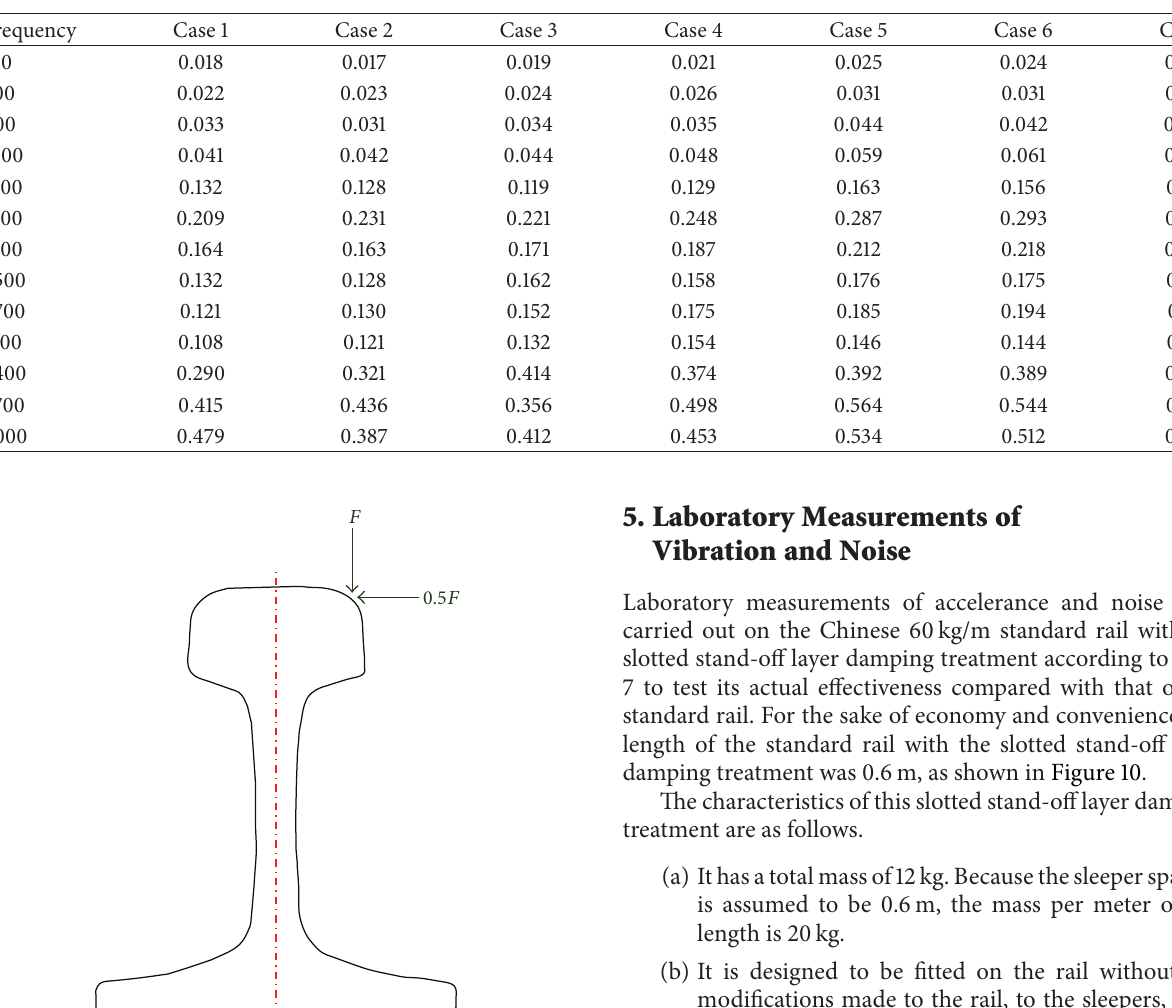
Table 2: Damping ratio 𝜂 of the seven cases.